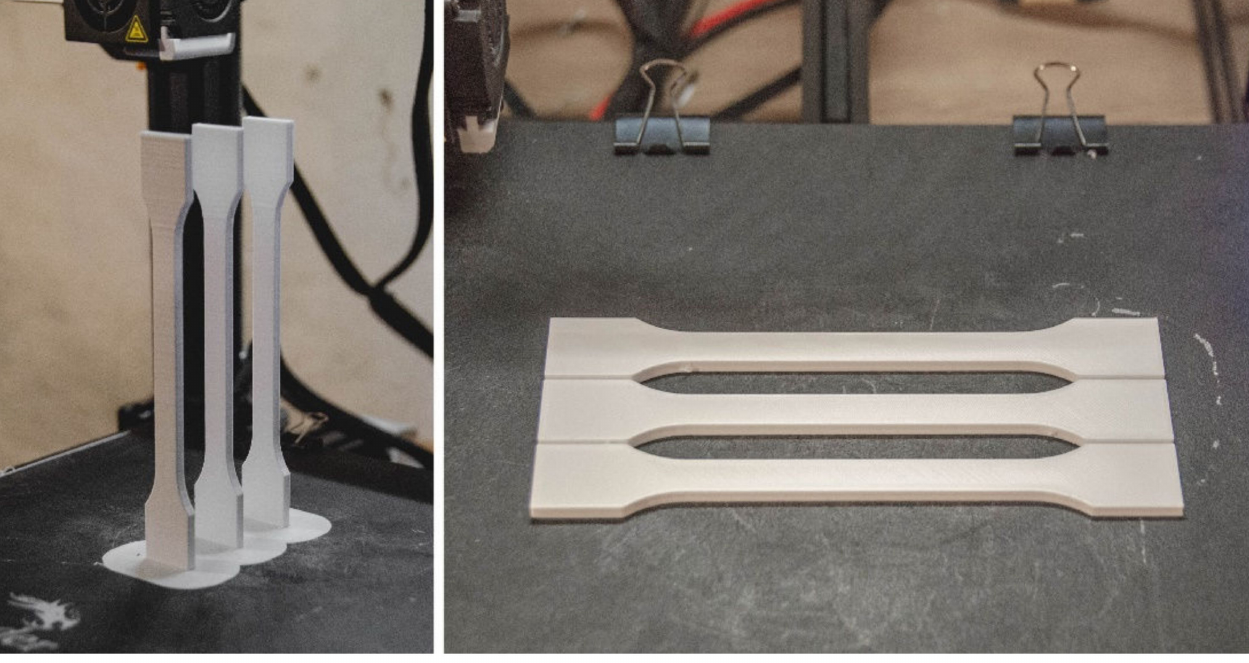
Figure 8. Specimens after the end of the manufacturing process on the